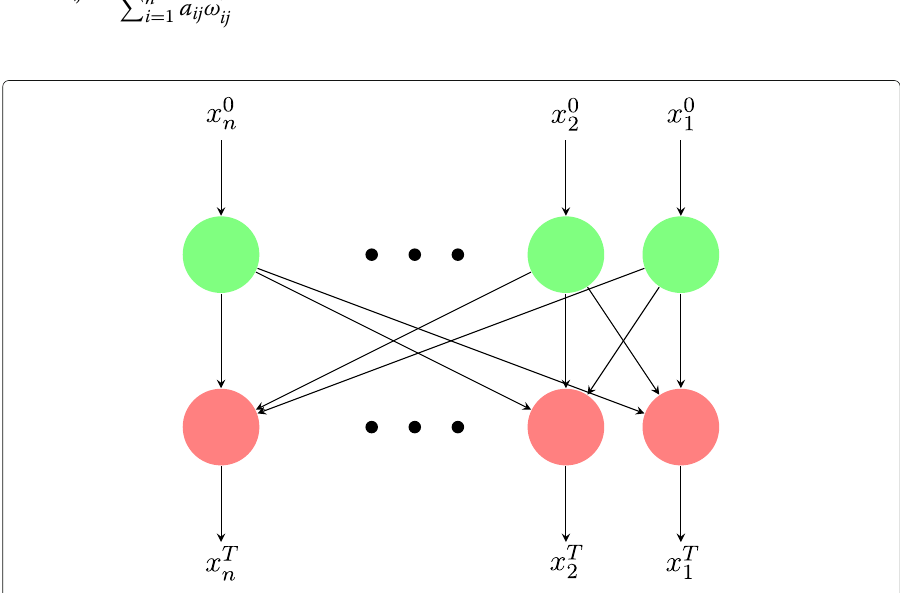
Fig. 1 Neural Network for Linear Threshold